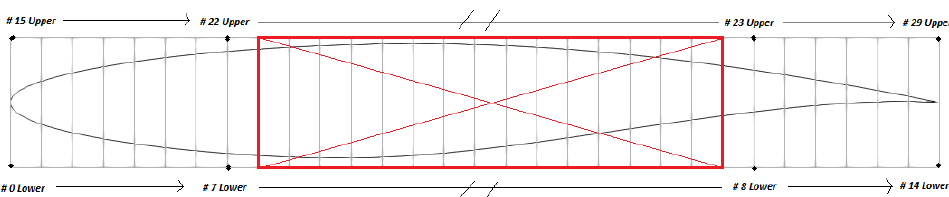
Figure 7. Control points defined for the FFD method that are used as design variables in the ASO process. The red box marks the hypothetical wing-box which control points remain fixed during the optimization.